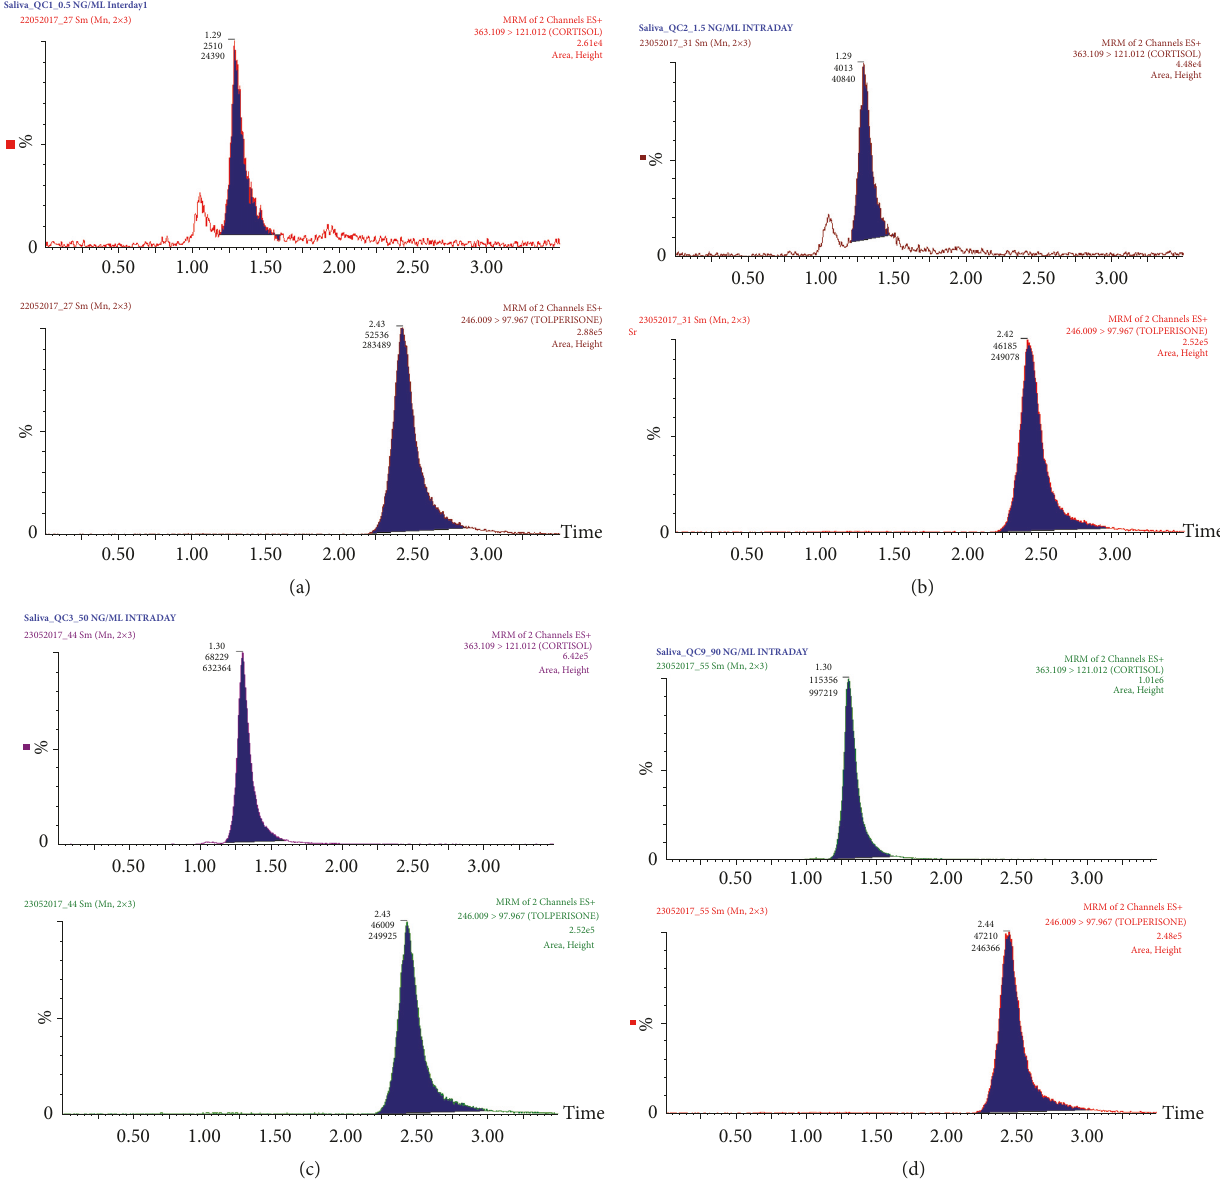
Figure 4: Multiple reaction monitoring chromatograms of four quality control samples ((a) 0.5, (b) 1.5, (c) 50, and (d) 90 ng/ml) spiked with 20 ng/ml internal standard